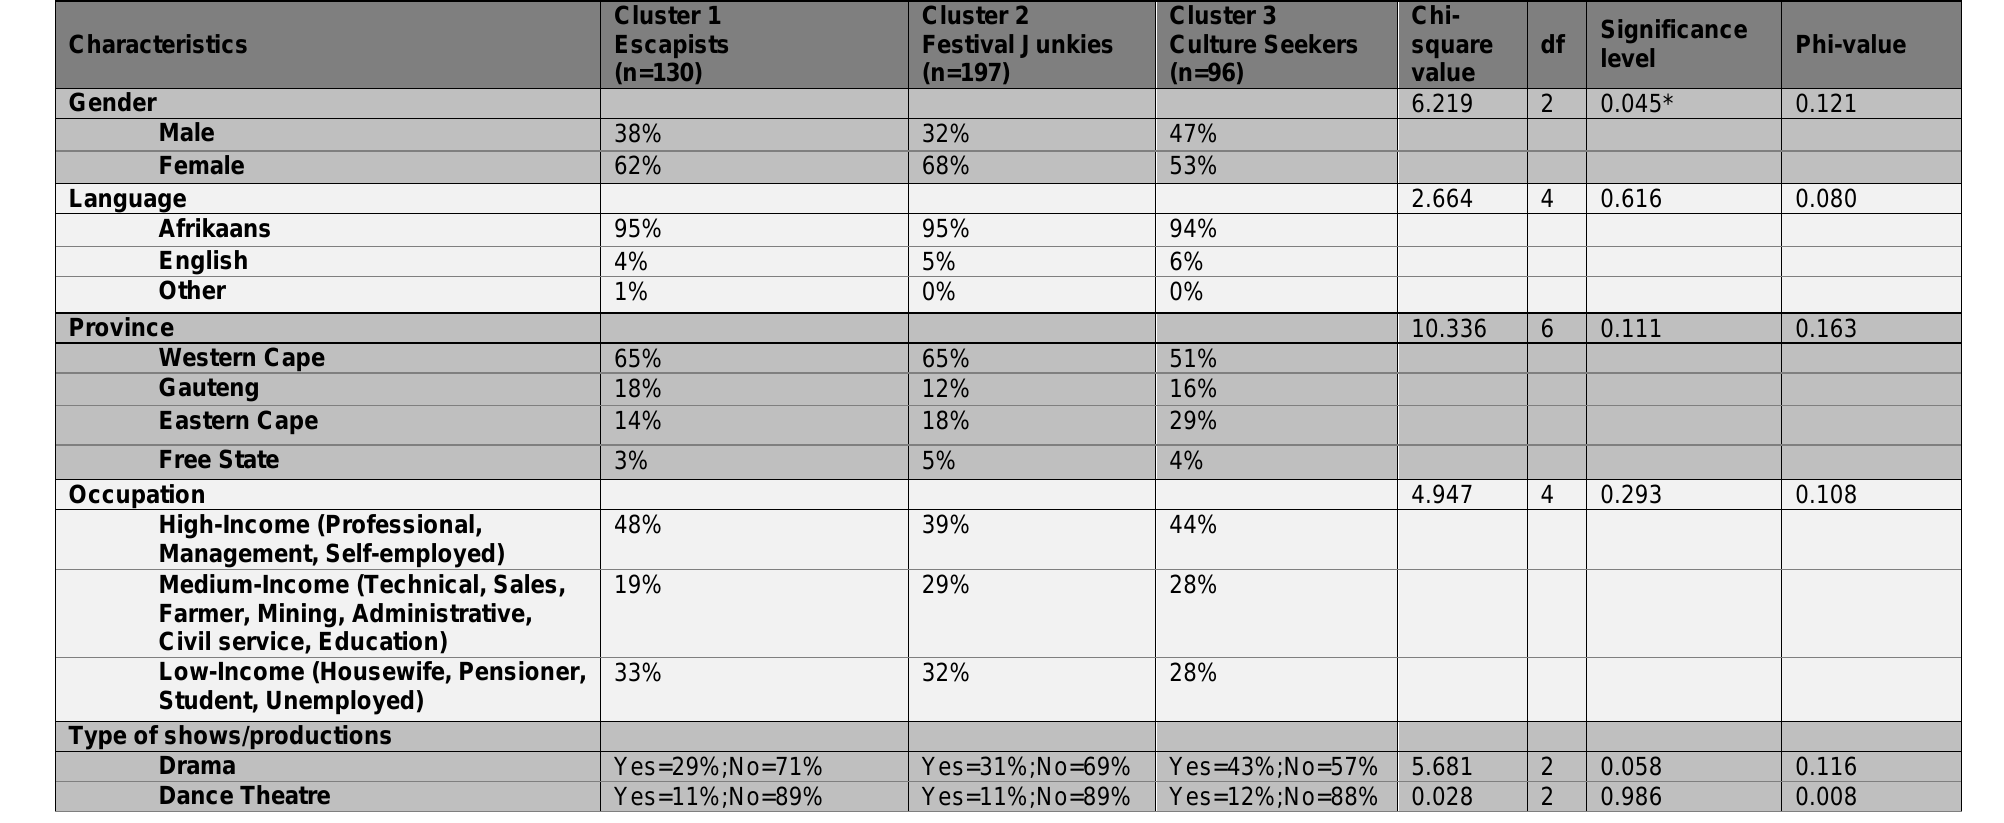
Table 5: Visitor characteristics of clusters